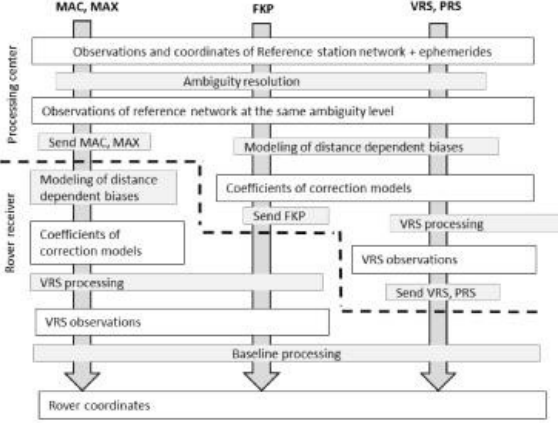
Figure 1: Principles of the NRTK methods and how the processing is divided between processing center and rover receiver. Modified from (Odijk & Wanninger,